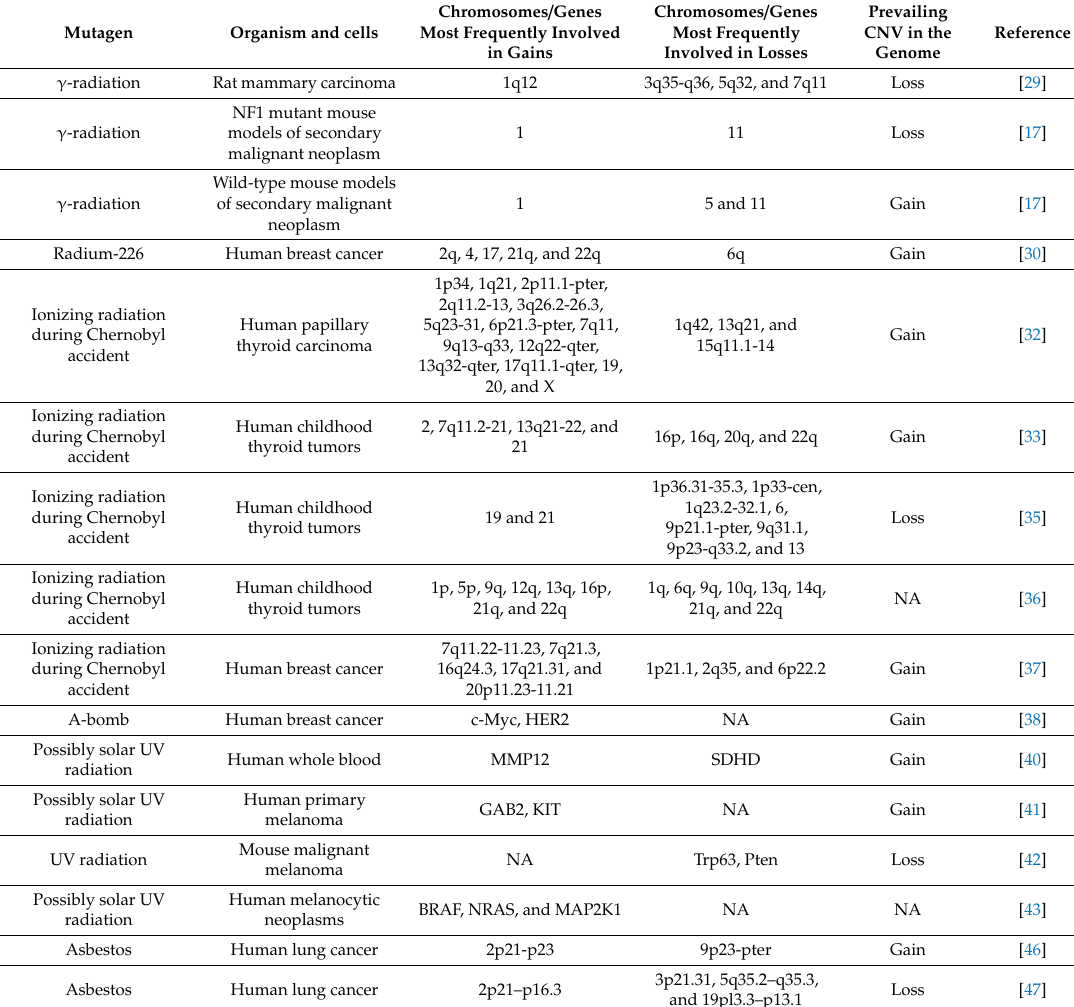
Table 2. Summary of studies on induction of CNVs using radiation and chemical mutagens in vivo with selected examples of deletion and duplication loci. NA = not